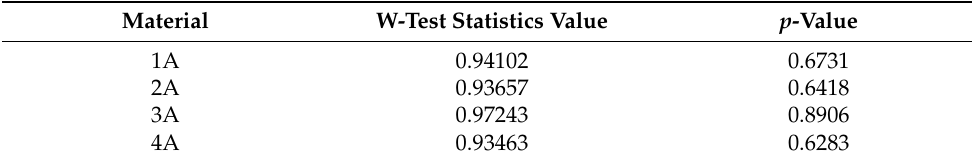
Table 2. S-W test results for Shore indentation hardness test values for individual materials.